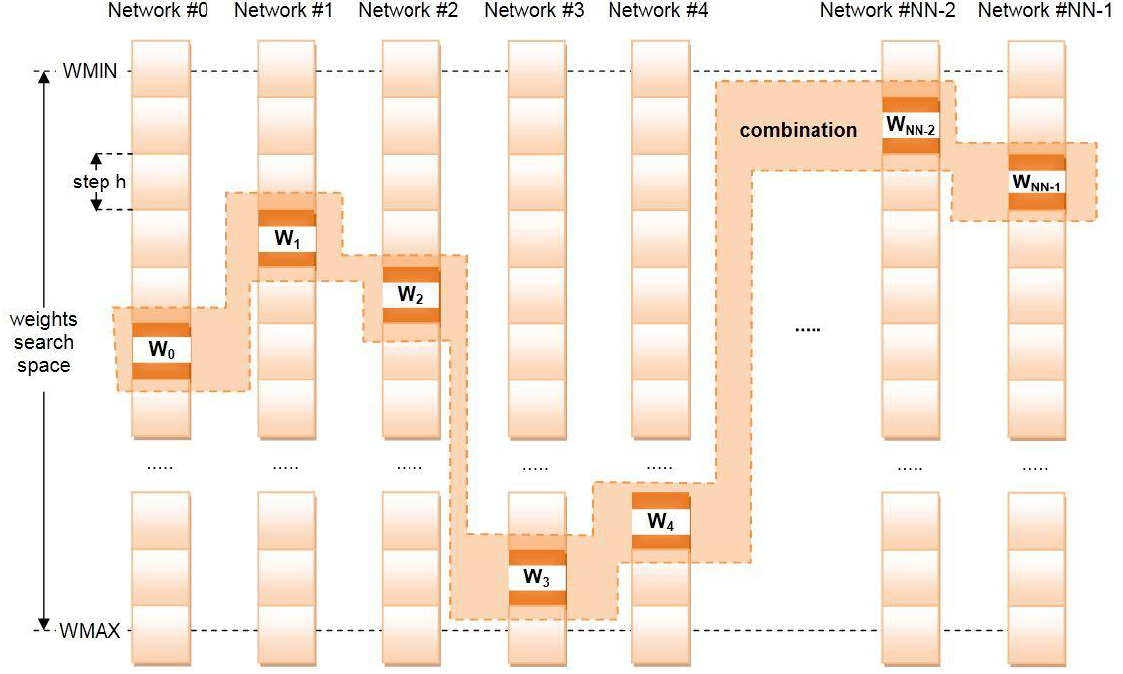
Figure 4. SEFI searches the best combination of QoS weights for different